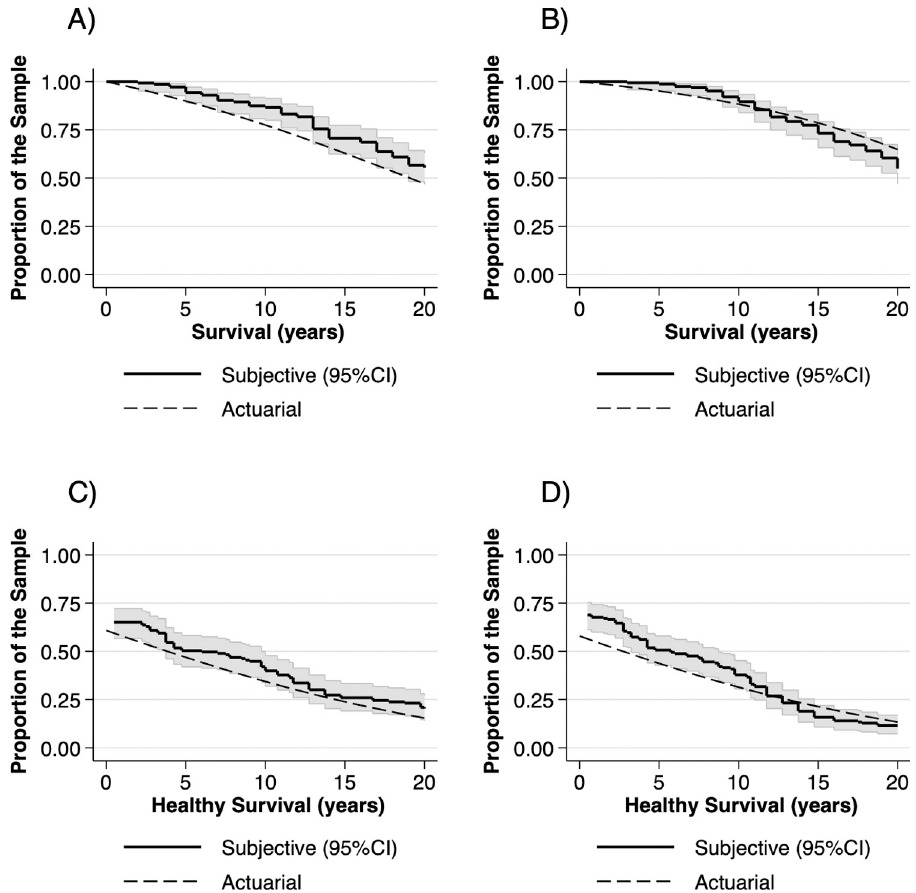
Fig 2. Comparison of 20-year actuarial and subjective curves of A) survival in men, B) survival in women, C) healthy survival in men and D) healthy survival in women in 50-65-year-olds. Actuarial survival curves were calculated for the sample age distribution via the cohort-compartment method, using conditional mortality data from the 2019 population life tables and estimated yearly conditional probabilities of becoming limited from the 2019 5-year-age- group healthy life expectancy (HLY) tables. Subjective survival curves were calculated from sample point estimates of subjective life expectancy (sLE) and imputed point-estimates of subjective healthy life expectancy (sHLE) from sLE point estimates and expected limitations at age 60,70 80 and 90 years measured by the adapted Global Activity Limitation Indicator (GALI) instrument.